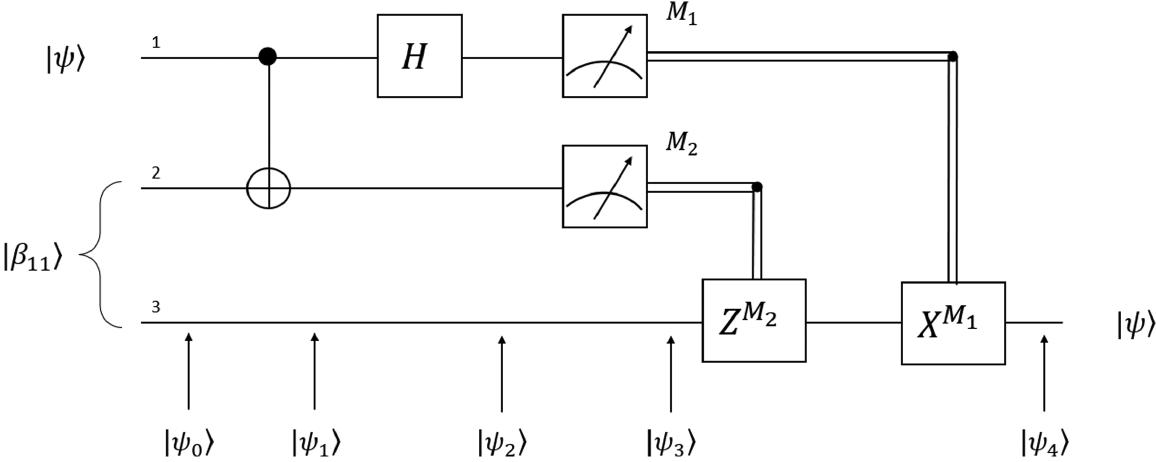
FIG.5. Teleportation circuit (redrawn from Ref. [5]).